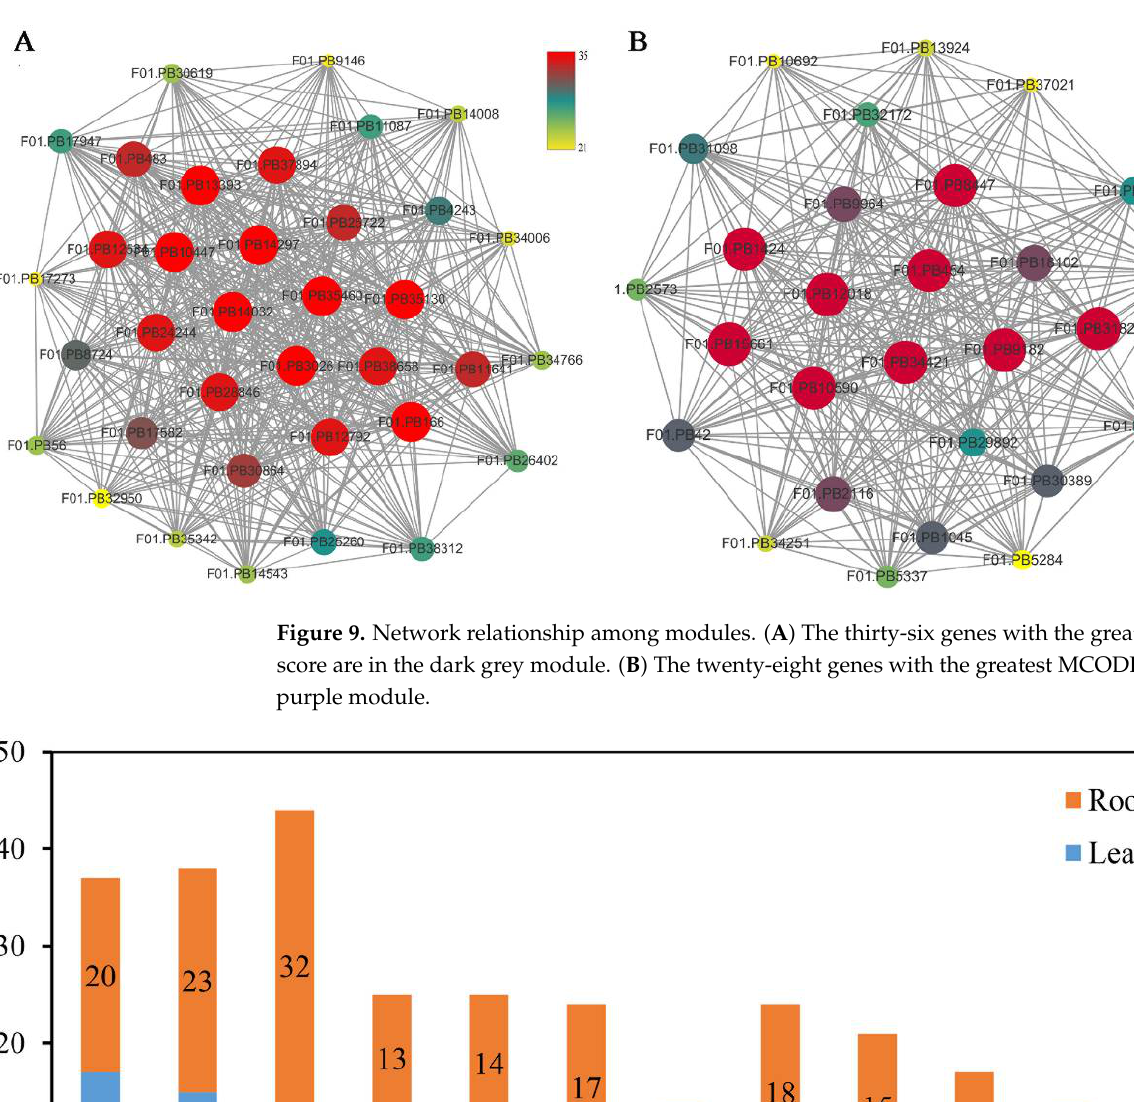
Figure 8. GO pathways associated with modules associated with stress-responsive traits. The num- ber ahead of the items indicates the gene number. ( A ) Dark grey module GO pathways. ( B ) Purple module GO pathways. Figure 9. Network relationship among modules. ( A ) The thirty-six genes with the greatest MCODE score are in the dark grey module. ( B ) The twenty-eight genes with the greatest MCODE score are in purple module.